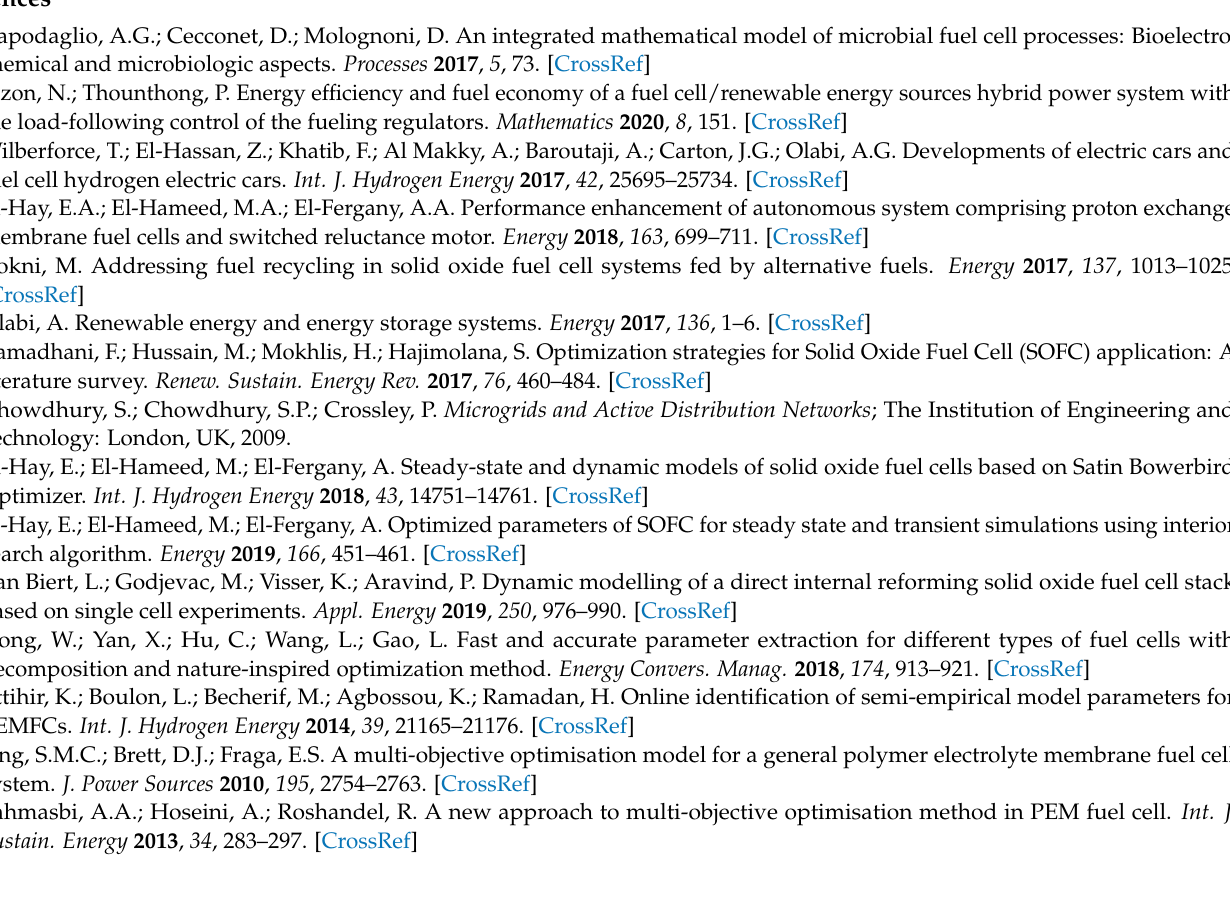
Algorithm (SPBO), Marine predator algorithm (MPA), Manta ray foraging